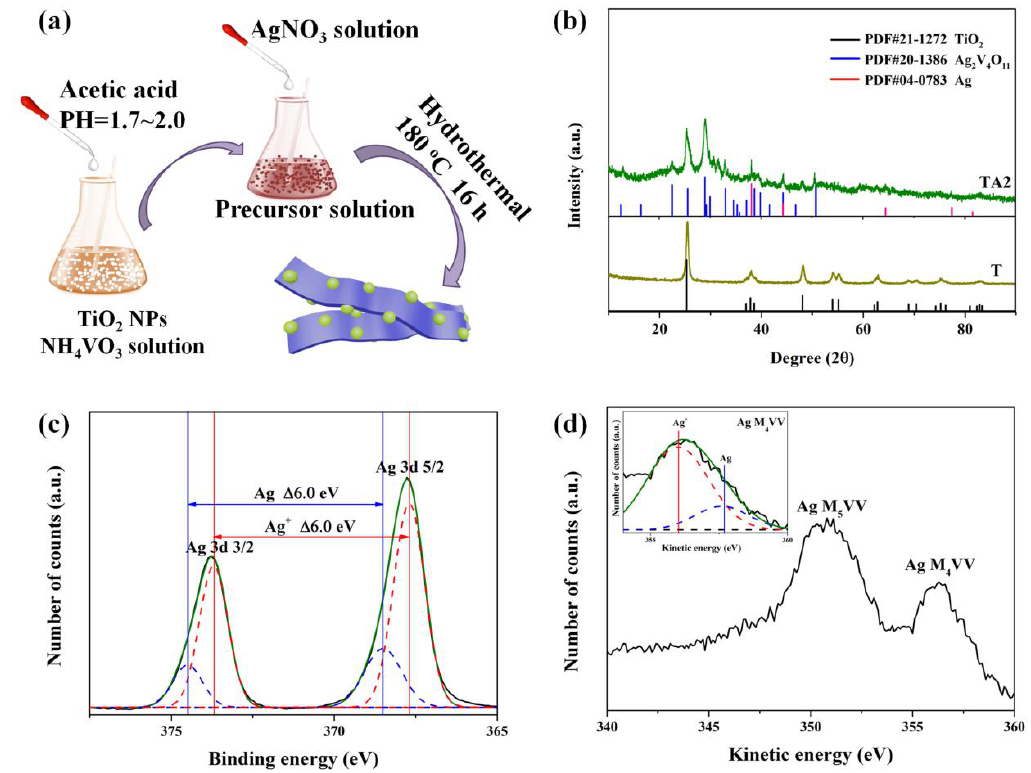
Figure 1. ( a ) Schematic of TiO 2 /Ag 2 V 4 O 11 nanoheterojunction’s synthesis process, ( b ) XRD patterns of TiO 2 (T) and TiO 2 /Ag 2 V 4 O 11 nanoheterojunction with set molar ratio of 2:1 (TA2) samples, XPS high- of TiO 2 (T) and TiO 2 / Ag 2 V 4 O 11 nanoheterojunction with set molar ratio of 2:1 (TA2) resolution spectra of ( c ) Ag 3d and ( d ) Ag MVV of the TA2 sample.